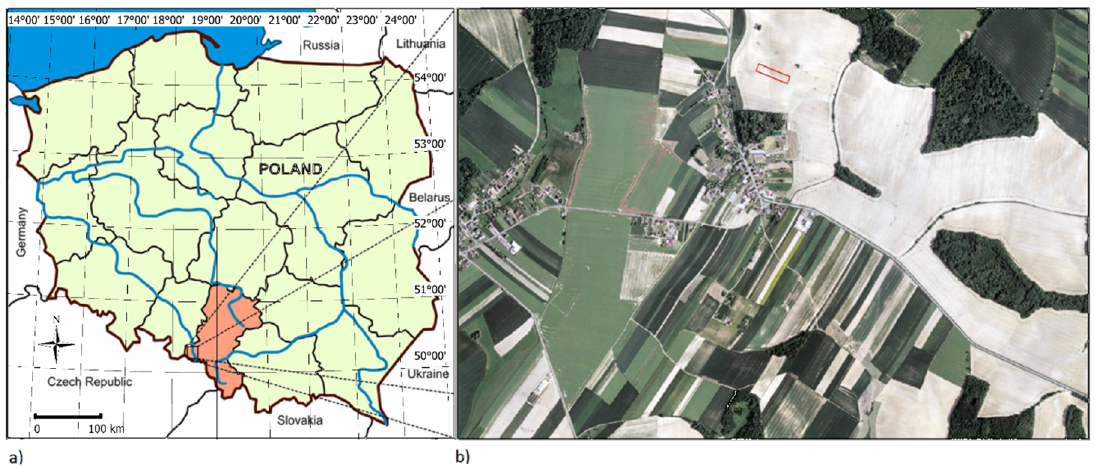
Figure 1. ( a ) Location of the investigation sites; ( b ) location of point borders.